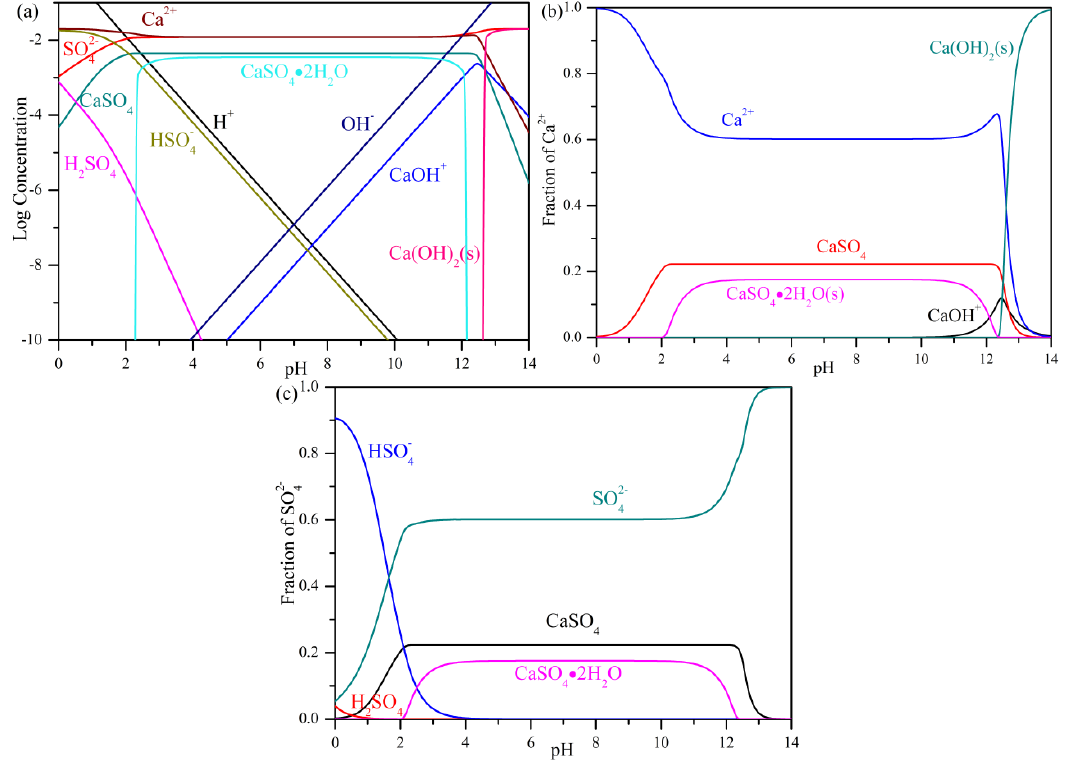
Figure 3. Calculated species distributions of 20 mM CaSO 4 at different pH: ( a ) with log concentration vs. pH; ( b ) with fraction of calcium vs. pH; ( c ) with fraction of sulfate vs. pH. Table2. CalculatedconcentrationsofdifferentspeciesinsaturatedCa(OH) 2 ,CaCO 3 ,andCaSO 4